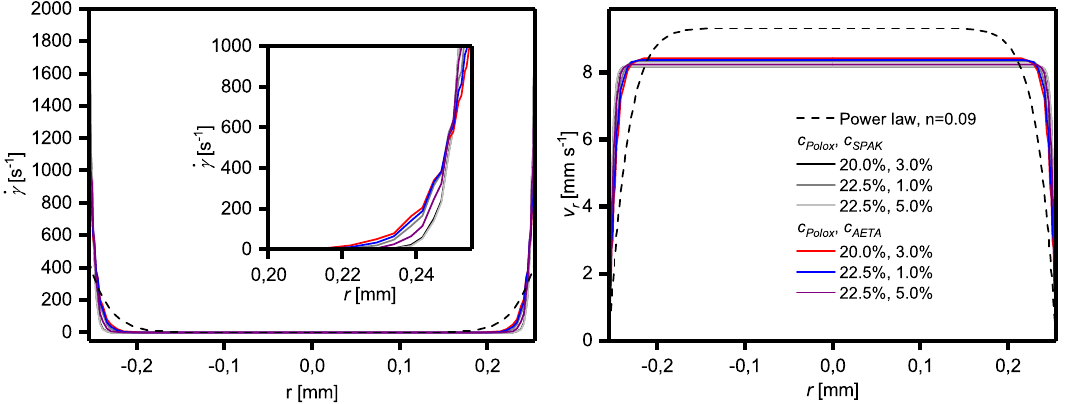
Figure 7. Calculated shear rate and velocity profiles of a power law liquid with n = 0.09 (dashed line), representative of formulations containing 17.5% Poloxamer 407, and of the different Herschel–Bulkley liquids from Table 2 which have a c Polox ≥